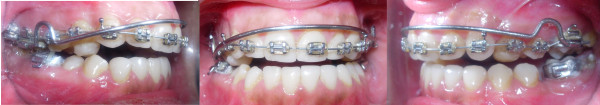
Heavy labial bow used as the expanding appliance for case 1.